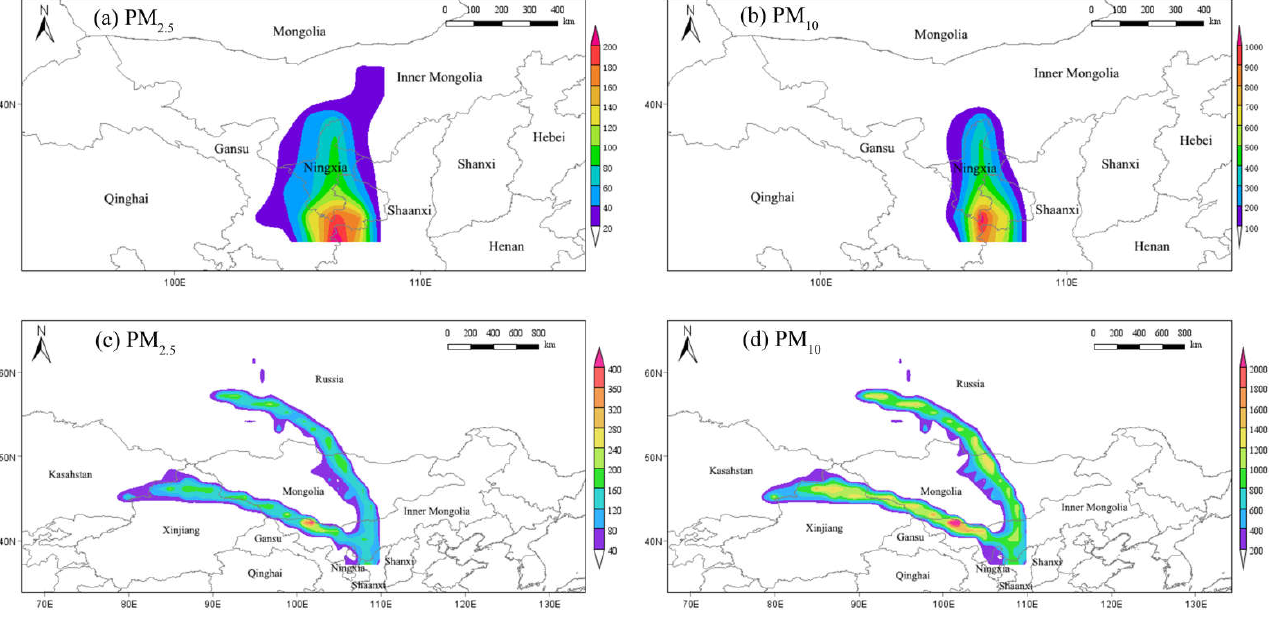
Figure 7. Weighted concentration weight trajectories (CWT) for PM 2.5 and PM 10 during non-sand- storm ( a , b ) and sandstorm ( c , d ) intervals.